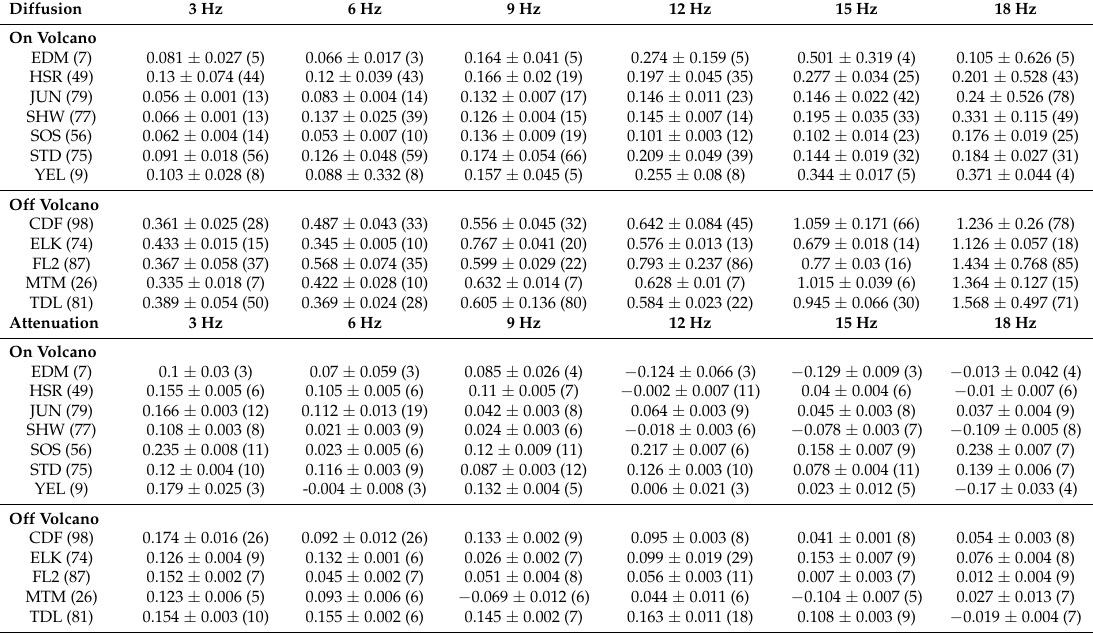
Figure 6. Example histogram plots for station HSR at 15 Hz. Coefficient averages were taken from the most populous bins to minimise the effects of poor data distribution and outliers distorting results. When two or more bins have the same number of counts an average is calculated between the minimum and maximum values of those bins. Table 1. Mean inversion results for the diffusion and attenuation coefficient values for each recording station with associated error. Values in brackets next stations are the total number of events used in the histogram count after NaN and infinite values have been removed. Values in brackets next to coefficient values are the total number of events used to calculate average values. Diffusion 3 Hz 6 Hz 9 Hz 12 Hz 15 Hz 18 Hz On Volcano